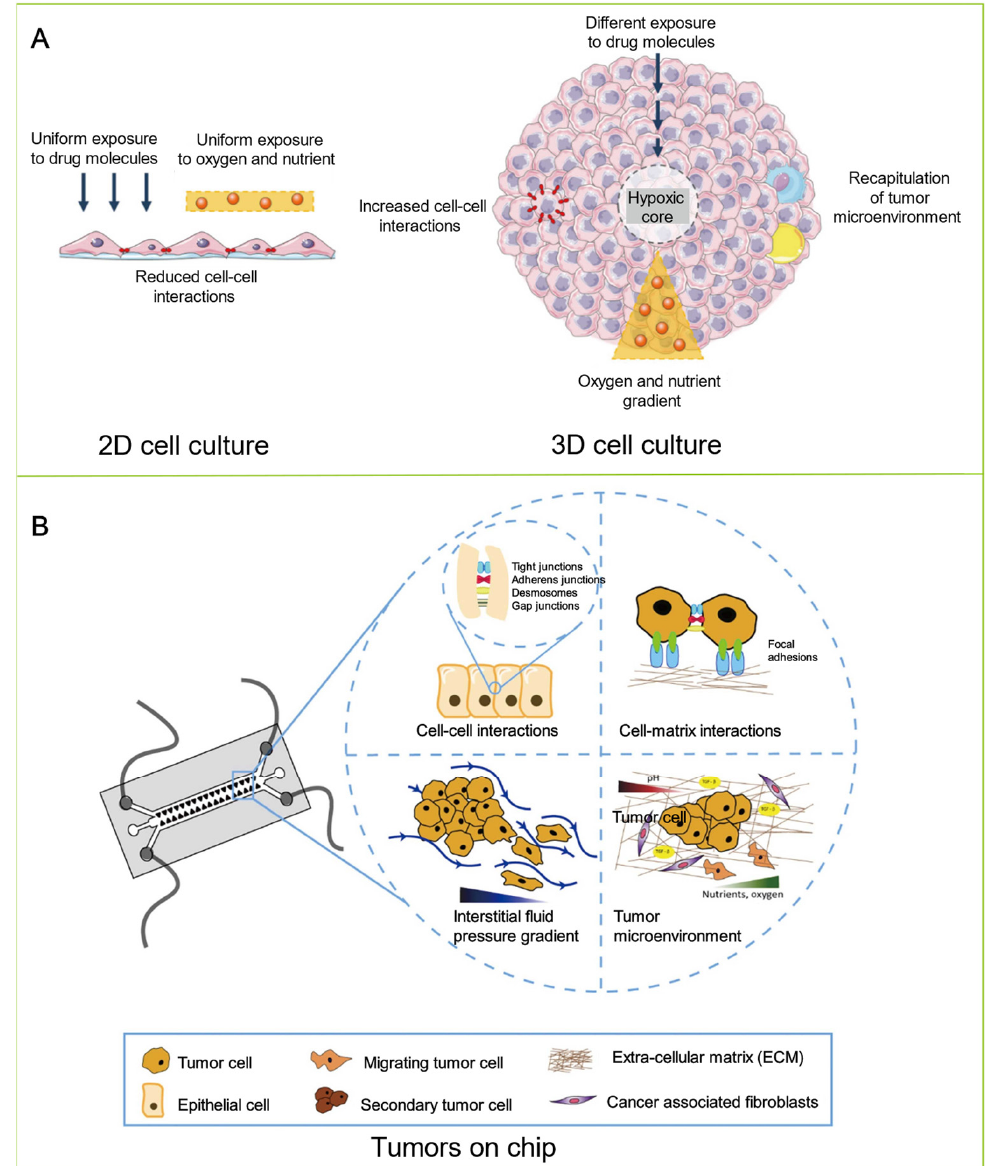
Figure 3. ( A ) The main differences between 2D and 3D cell cultures. Adapted with permission